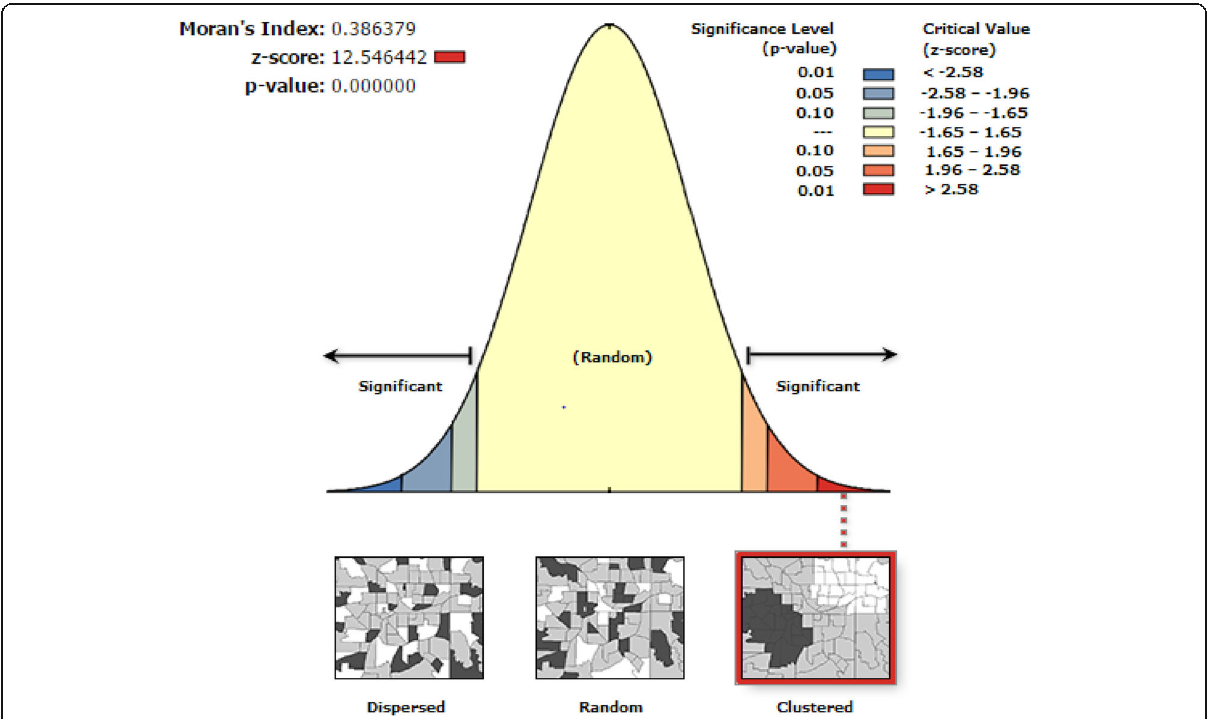
Fig. 2 Global spatial autocorrelation based on feature locations and attributes values (immunization defaulters) across the study areas among children aged from 12 to 23 months in EDHS 2016